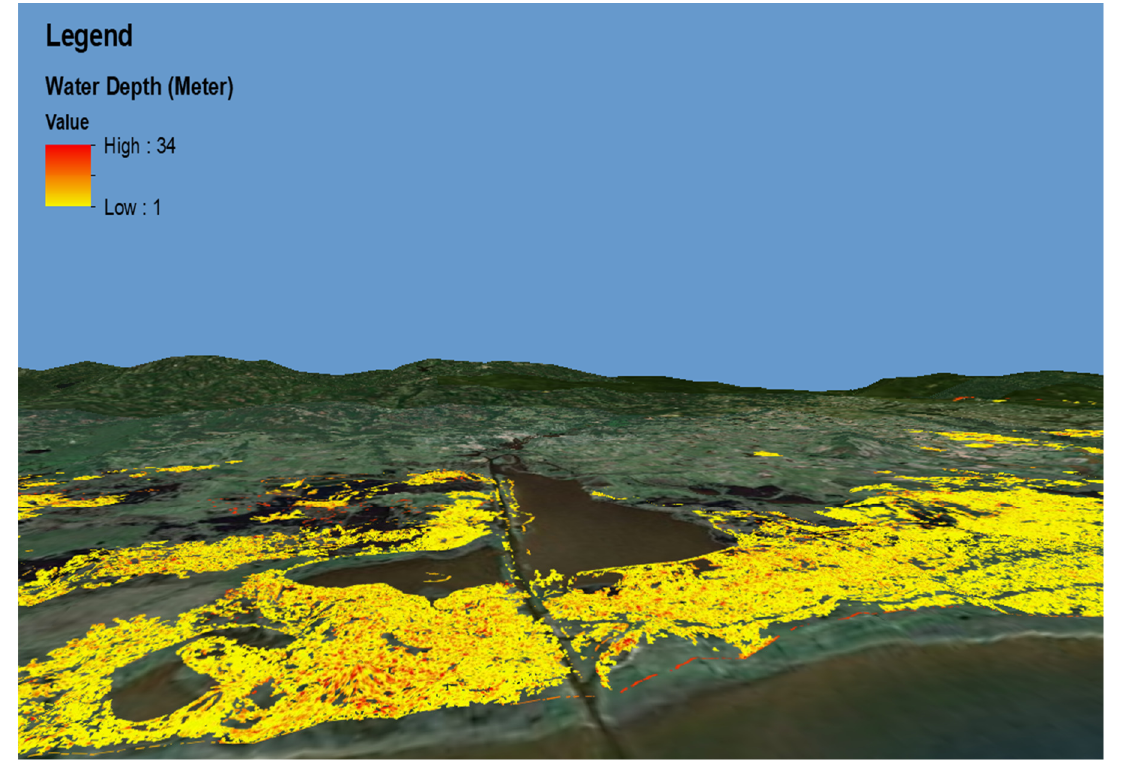
Figure 8. The 3D view of VIIRS downscaled 30 m floodwater depths in the West Gulf region due to Hurricane Laura on 29 August 2020.